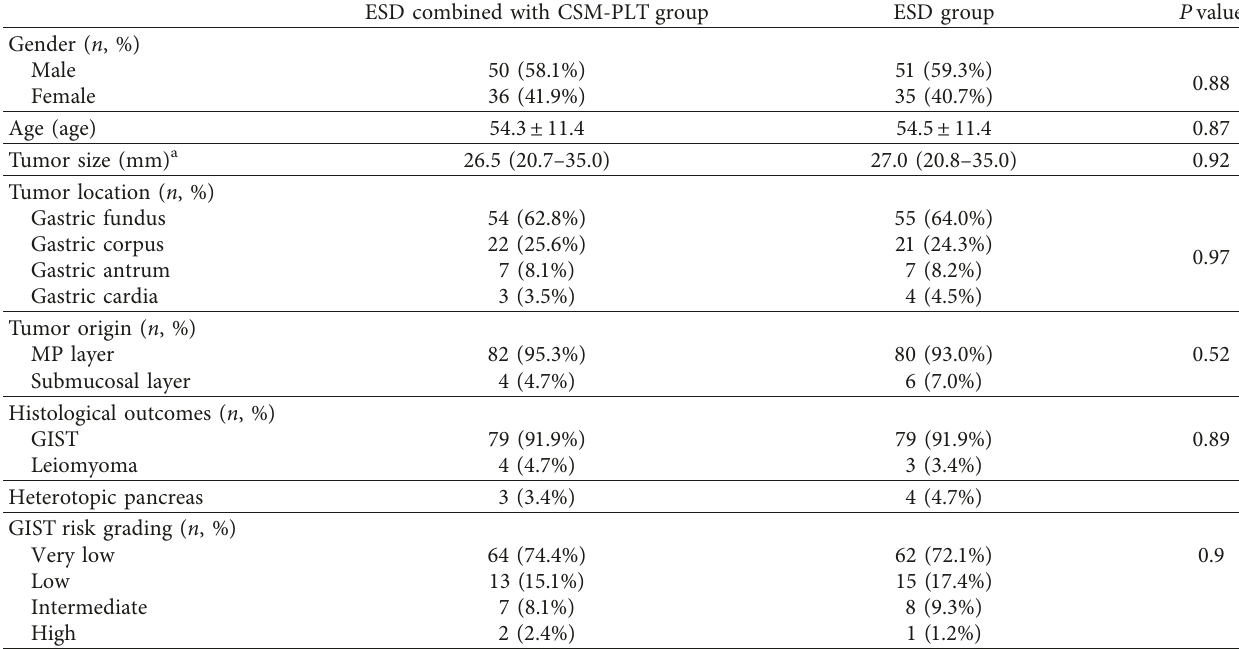
Table 1: Baseline characteristics.